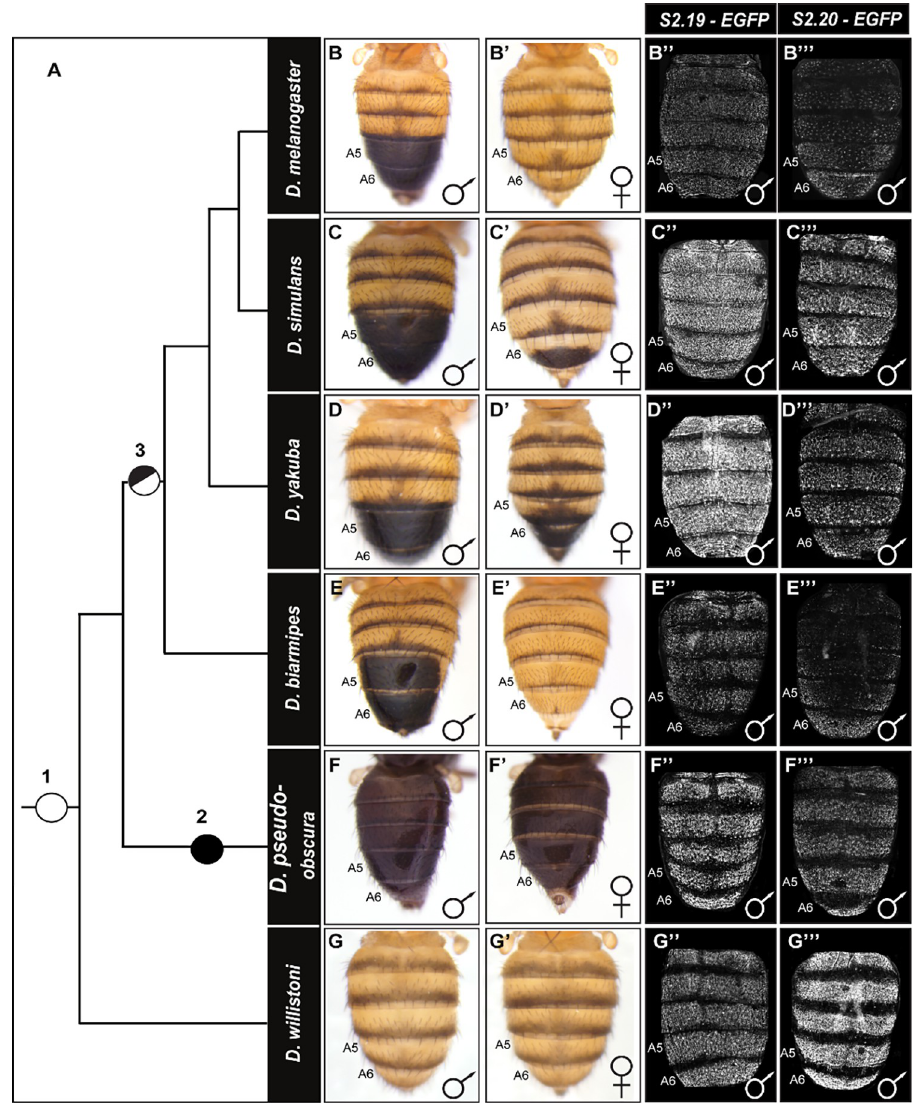
Fig 8. The evolution of tergite pigmentation and trx CRE activity in the D . melanogaster lineage. (A) Phylogeny showing the relationship of various Sophophora species with nodes indicating the origin of male-specific tergite pigmentation, and the placement of ancestral pigmentation phenotypes. It is generally accepted that the ancestor at nodes 1 and 2 had monomorphic tergite pigmentation patterns, with the node 2 ancestor being broadly melanic in color. Node 3 indicates the origin of sexually dimorphic pigmentation, where male tergites were fully melanic in color. Adult tergite pigmentation phenotypes for representative (B-G) males and (B’-G’) females. EGFP reporter expression patterns in transgenic D . melanogaster that were driven by sequences orthologous to the (B”-G”) S2 . 19 and (B”‘-G”‘) S2 . 20 CREs of D . melanogaster . The EGFP expression patterns demonstrate the conservation of ancestral pupal abdomen epidermis regulatory activities. However, some differences are seen among the orthologous sequences in the pattern and intensity of EGFP reporter